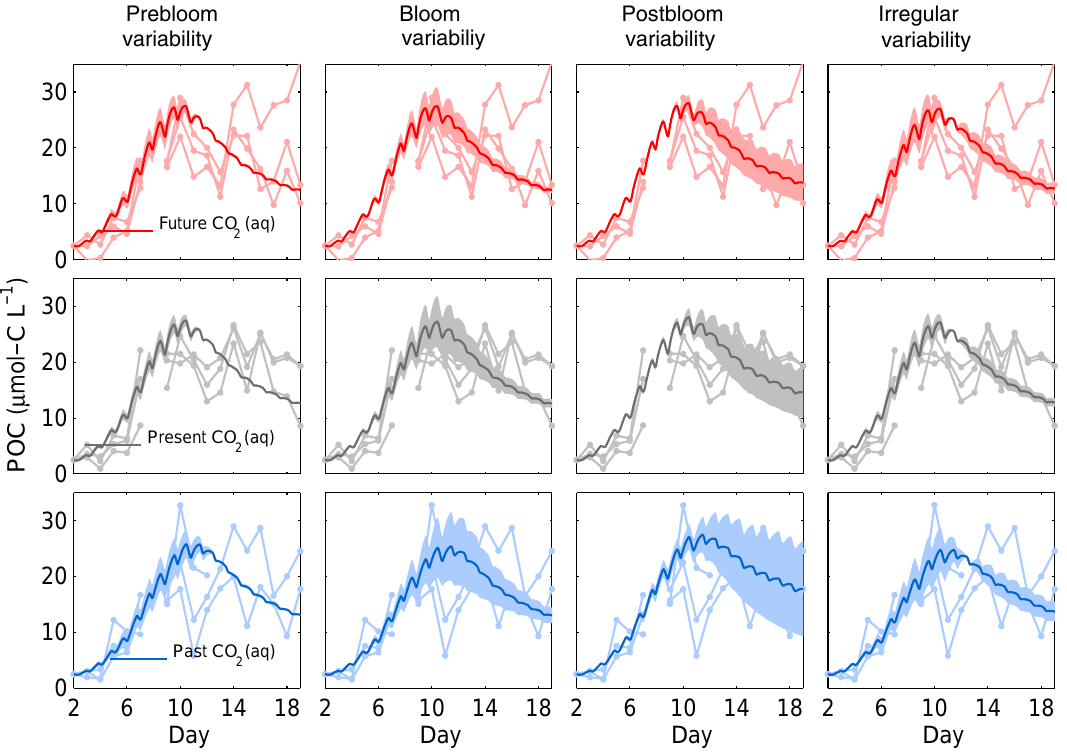
Figure 5. POC variability decomposition per factor, (cid:52) POC mod for PeECE II. Shaded areas are limited by the standard deviation of 10 4 i simulated POC time series (see Sect. 2), around the mean trajectory of the ensemble (solid line). The timing of the amplification of the variability determines four separated kinds of behavior: factor uncertainties generating variability during the prebloom, bloom, postbloom, or at irregular phase (see Sect.